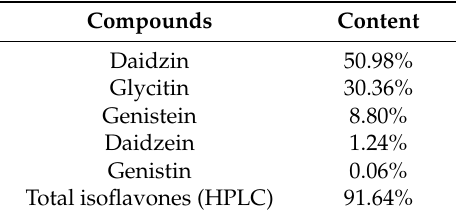
Table 4. Composition of the soy isoflavones